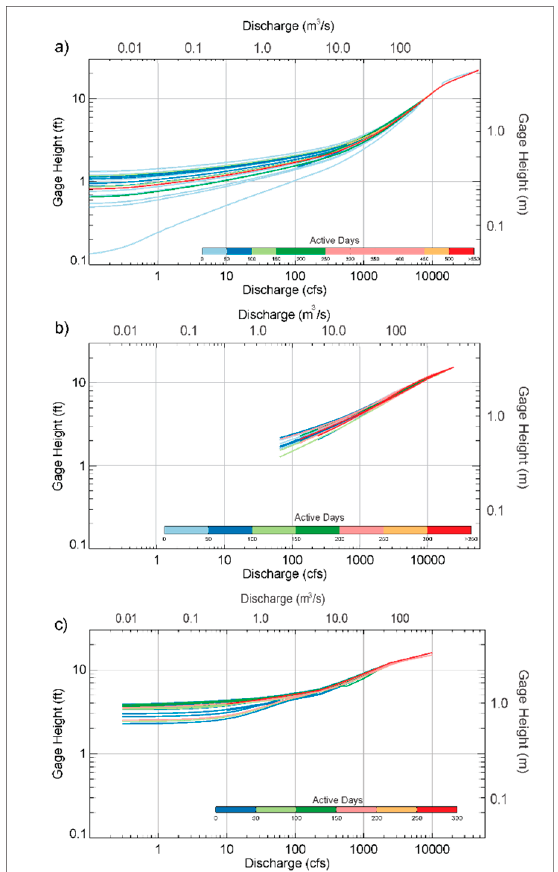
Figure 16. Duration of each rating curve (in days). ( a ) Skunk River at Merrimac; ( b ) Wapsipinicon River at Oxford Mills; and ( c ) Little Sioux River near Spencer.